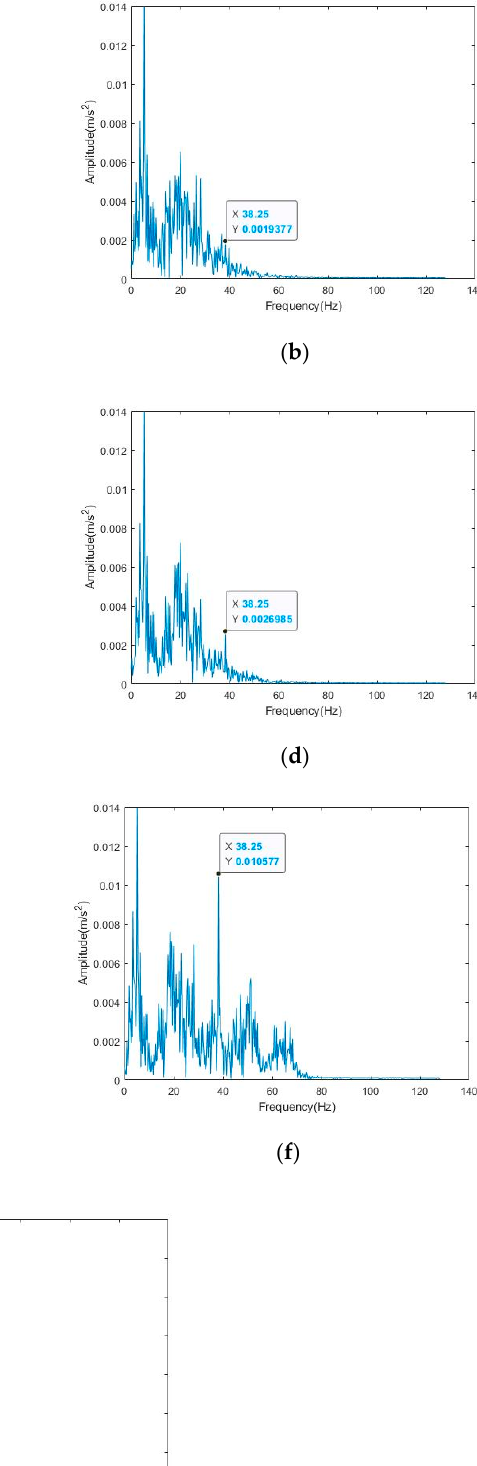
Figure 8. Time domain diagram of x -axis signal before and after denoising: ( a ) EMD denoising method; ( b ) EEMD denoising method; ( c ) CEEMD denoising method; ( d ) bilateral filtering de-